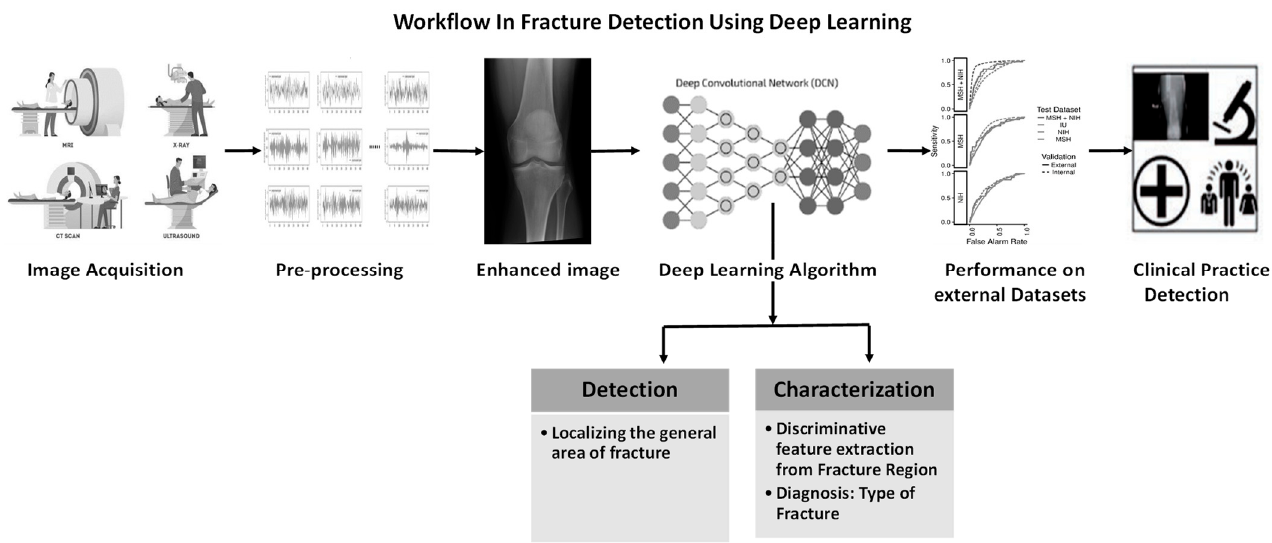
Figure 3. Workflow in fracture detection using deep learning.